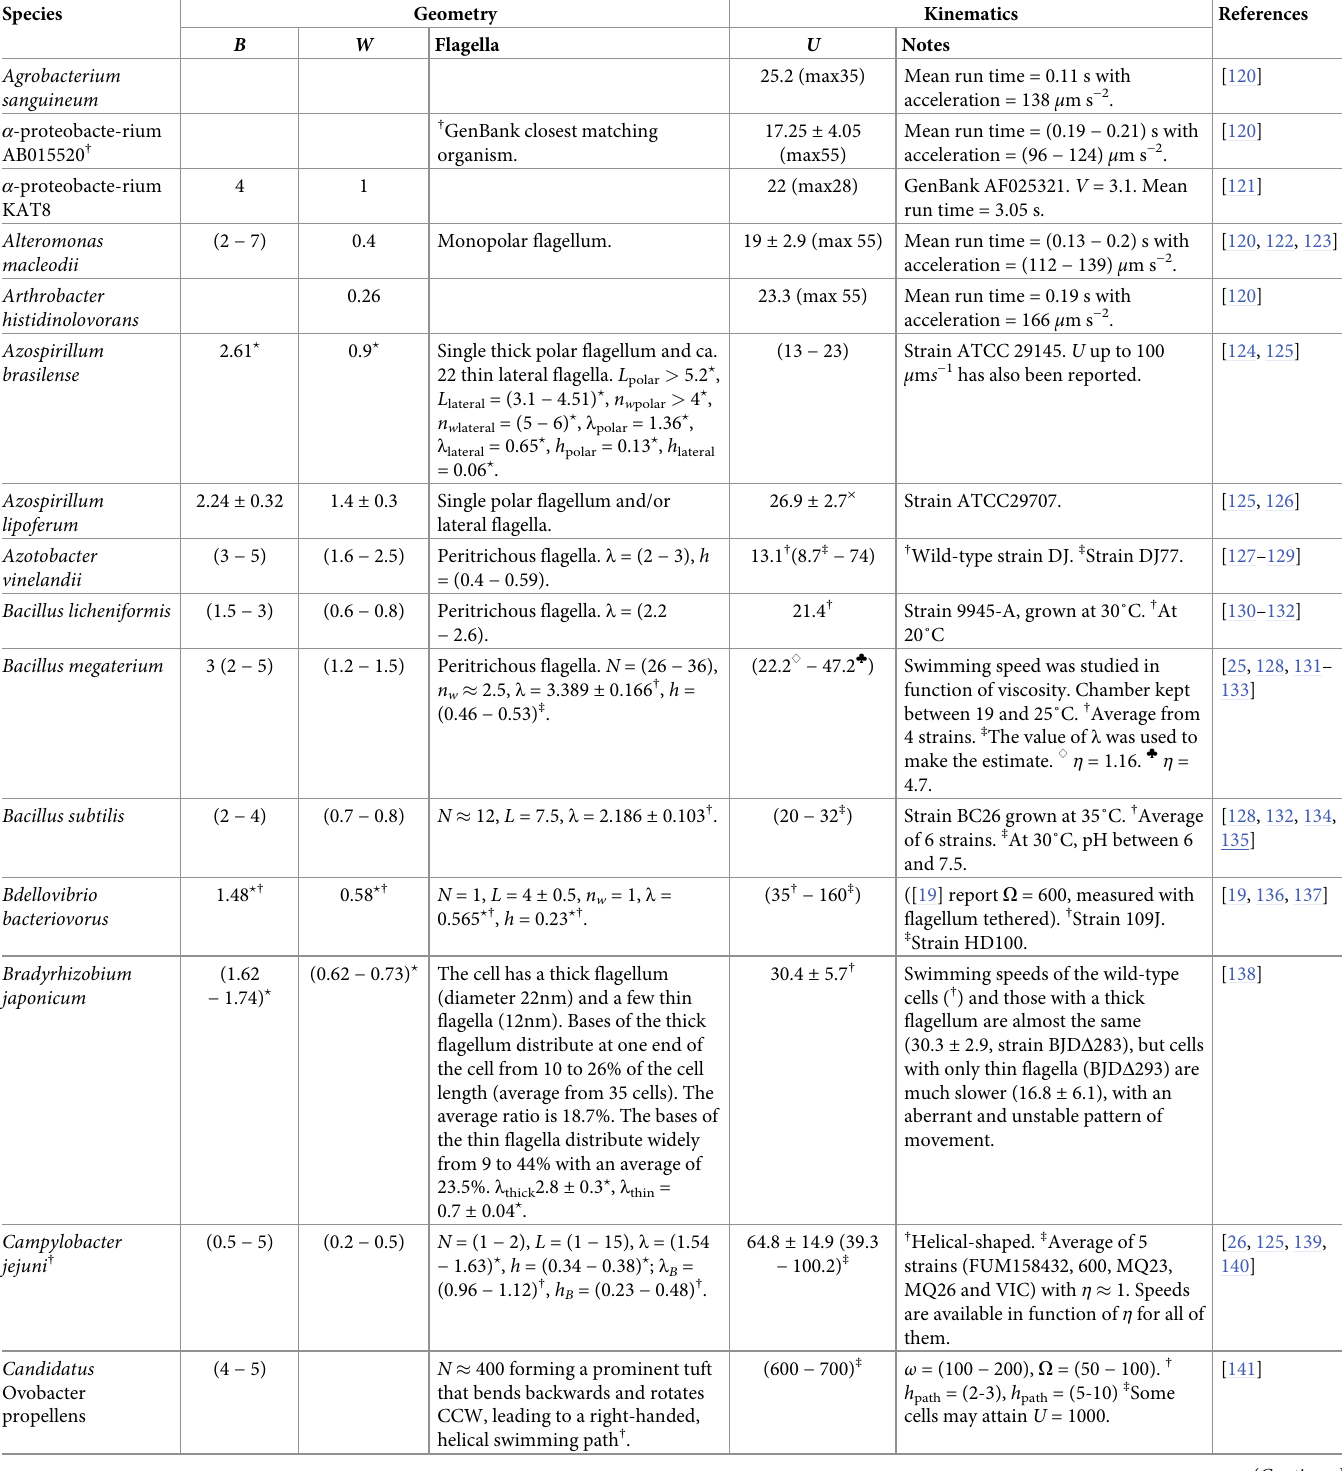
Table 4. Data for swimming bacteria (Spirochaetes and Spiroplasma excluded).